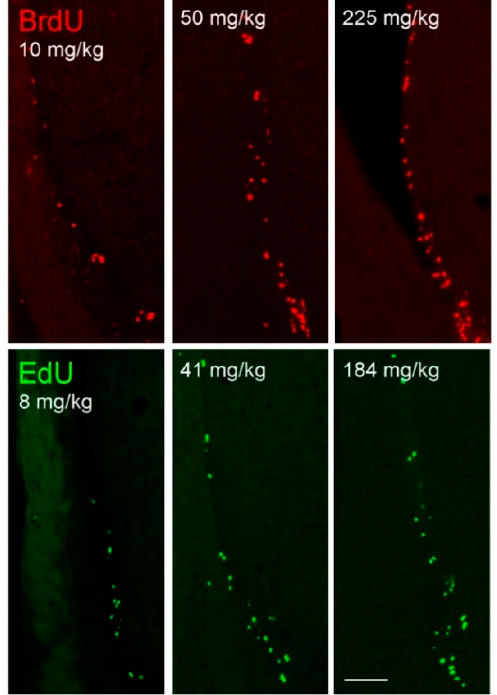
Figure 4. Fluorescent immunohistochemical labeling of BrdU (red) and fluorescent detection of EdU (green) after injection of different doses of the proliferation markers. Images show VZ TSM after 10, 50, and 225 mg/kg BrdU or equimolar doses of EdU. BrdU was detected by the antibody OBT0030. The dose 50 mg/kg of BrdU resulted in more labeled cells than the dose 10 mg/kg but did not differ from the dose 225 mg/kg. The same applies for equimolar doses of EdU. Medial is left, lateral is right. The white scale bar in the last image represents 100 μ m.